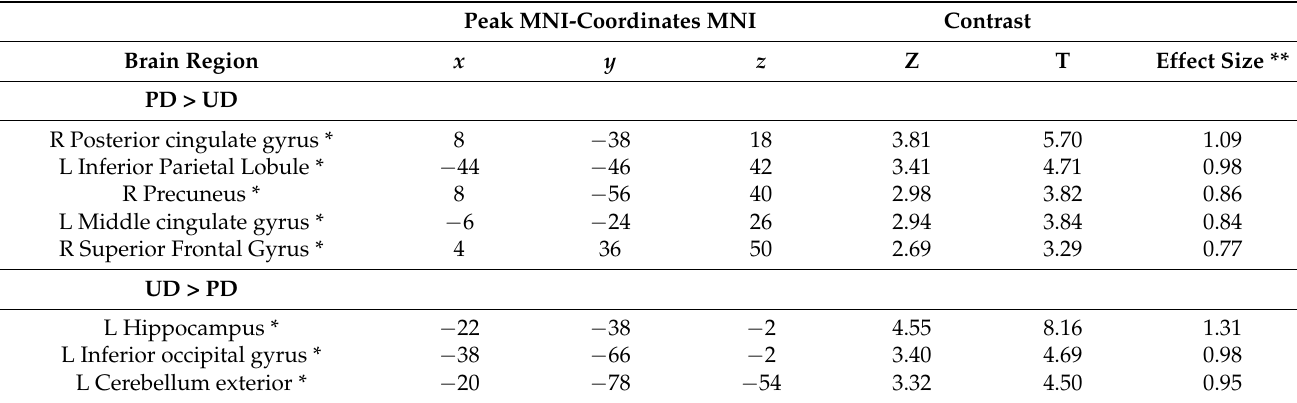
Table 1. Brain regions with stronger activation in response to pleasant (PD × RD + PD × ED) vs unpleasant (UD × RD + UD × ED) dishes.